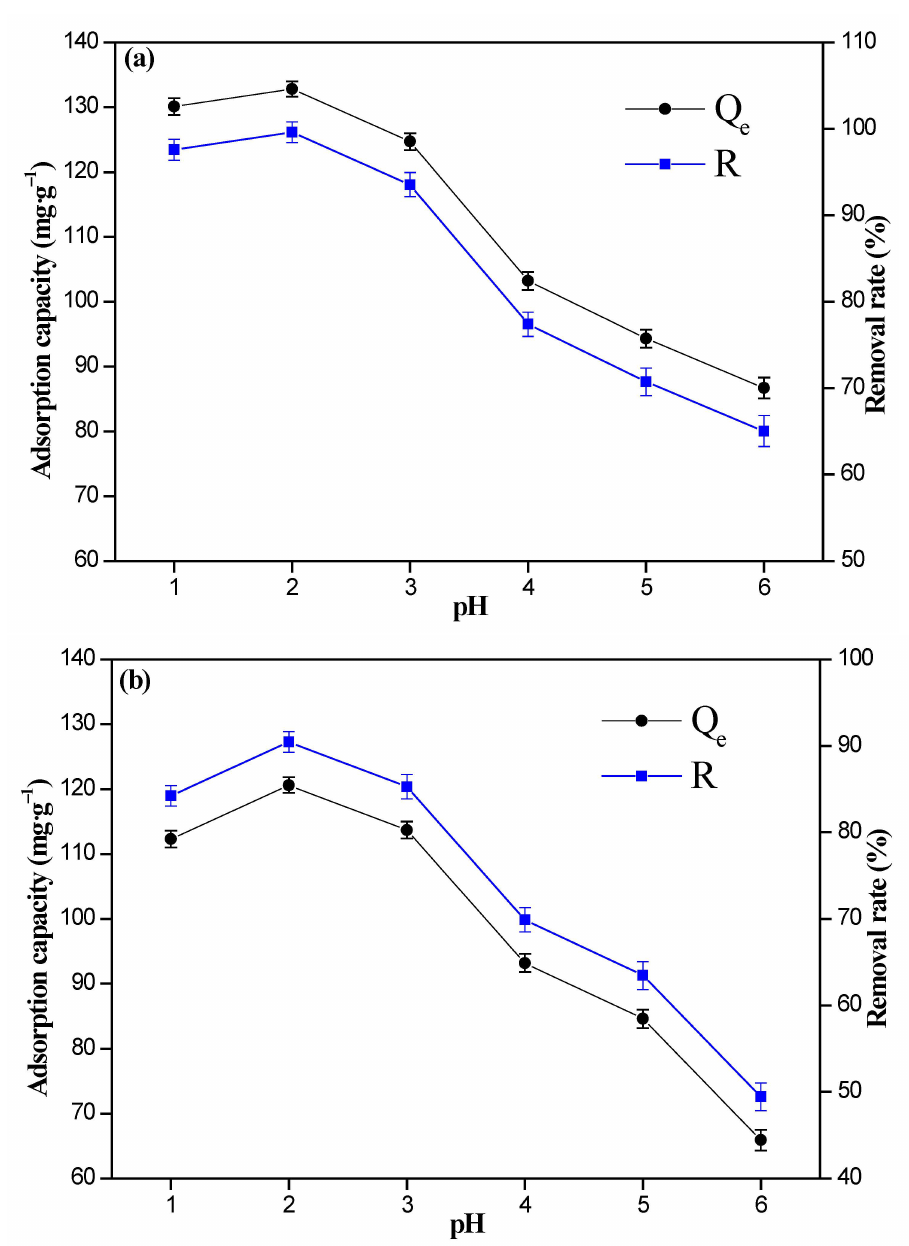
Figure 8. Effect of pH value on the sorption of Cr(VI) ions: ( a ) 8%Fe 3 O 4 @MMC and ( b ) 8%Fe 3 O 4 @MAC. Adsorption conditions: the initial Cr(VI) ions’ concentration, 80 mg · L − 1 ; volume, 50 mL; adsorbent dosage, 0.03 g; temperature, 298 K; adsorption time, 180 min. The adsorption capacity of 8%Fe 3 O 4 @MMC and 8%Fe 3 O 4 @MAC showed that a similar variation tendency, adsorption capacity of the adsorbent, and removal rate reached the